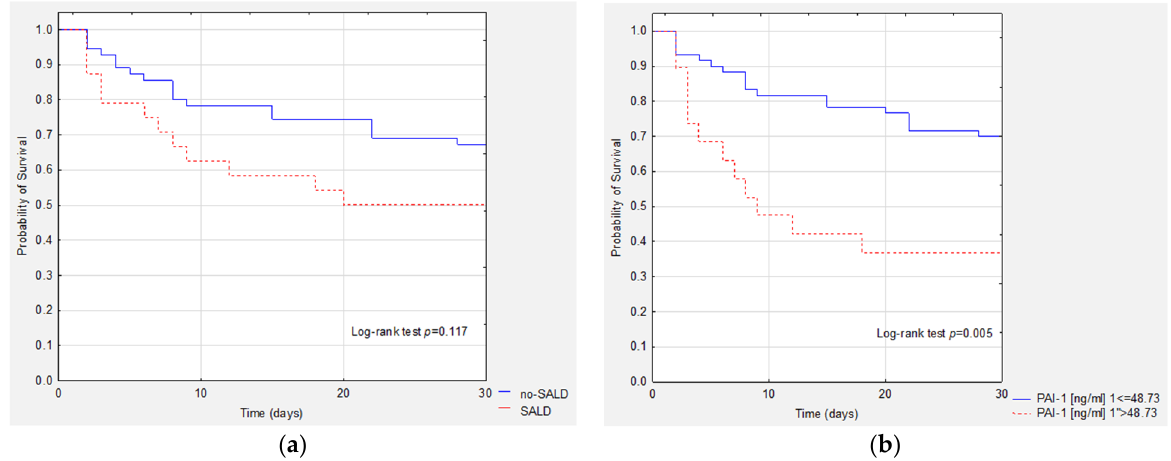
Figure 4. Kaplan–Meier survival curves for: ( a ) bilirubin—comparison between the SALD and no-SALD groups; ( b ) PAI-1.